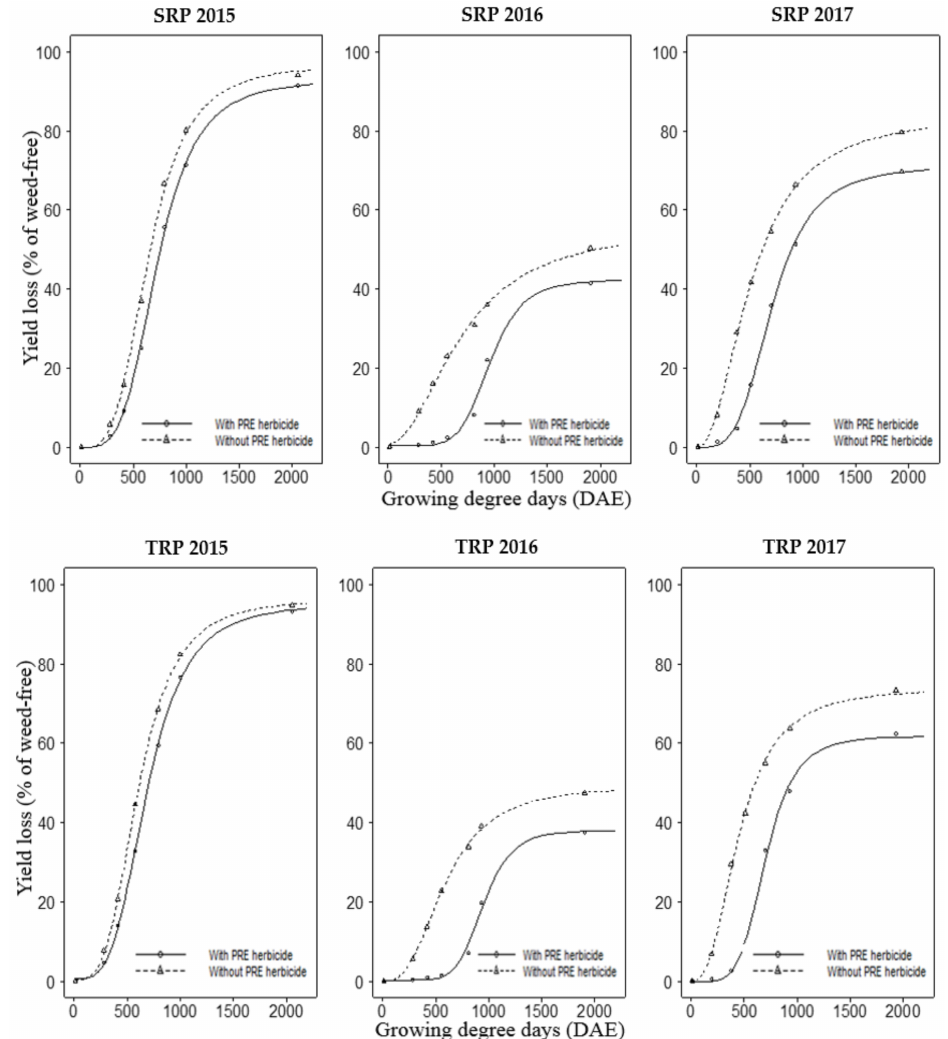
Figure 3. Corn yield loss (% of weed-free) response to increasing duration of weed interference as represented by growing degree days (DAE) grown without PRE herbicide and with PRE herbicide applications in standard row (SRP) and twin-row (TRP) planting patterns, at Padina, Serbia,